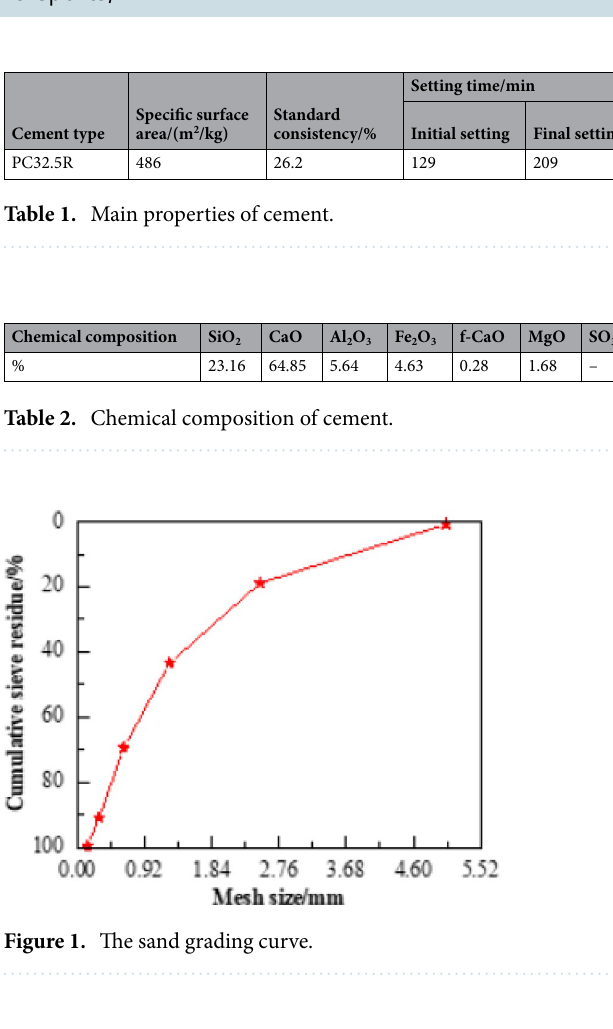
Table 1, and the chemical composition is shown in Table 2. Coal ash: Low calcium Grade I coal ash produced by Hancheng Power Plant. Fine aggregate: volume weight: 2730 kg/m 3 , fineness modulus: 2.68, bulk density: 1450 kg/m 3 , and silt content: 1.0% of Ba river medium sand. The sand grading curve is shown in Fig. 1. Coarse